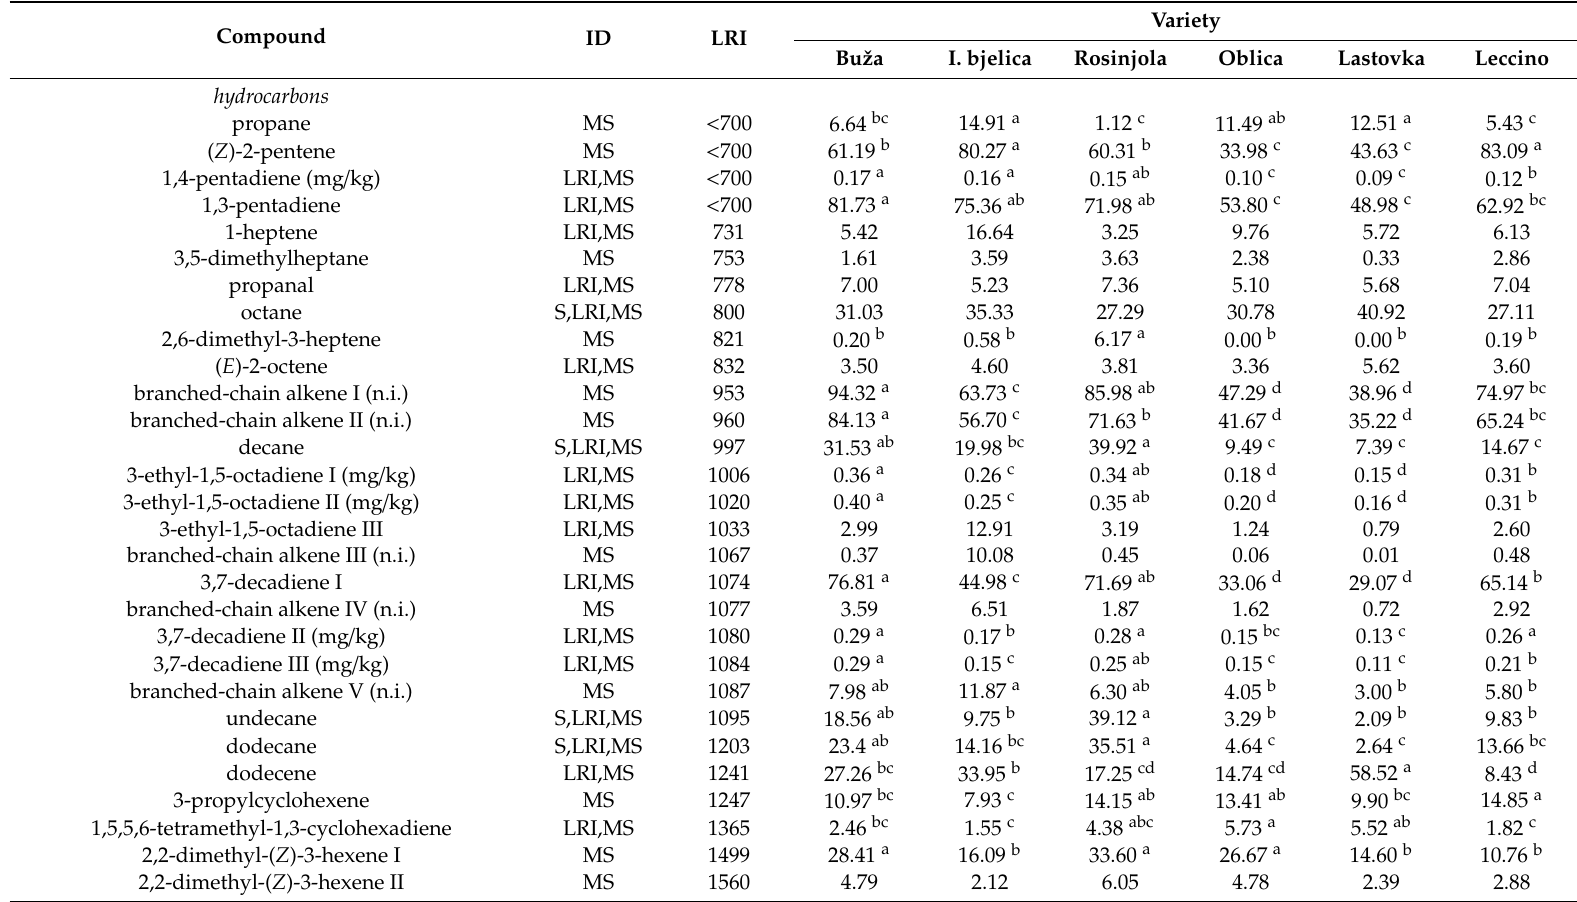
Table 1. Concentrations ( µ g / kg unless otherwise stated) of volatile aroma compounds determined by gas chromatography-ion trap mass spectrometry (GC-IT-MS) after headspace solid-phase microextraction (HS-SPME) from monovarietal extra virgin olive oils produced from Buža, Istarska bjelica, Rosinjola, Oblica, Lastovka, and Leccino varieties in